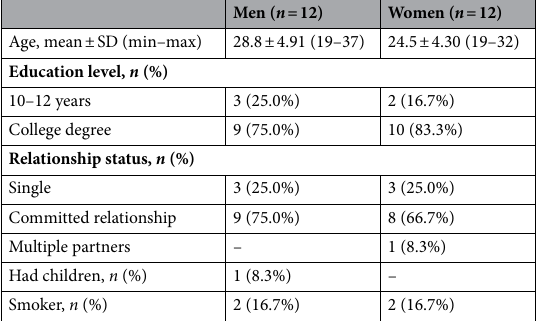
Table 1. Sociodemographic characteristics of participants (n =